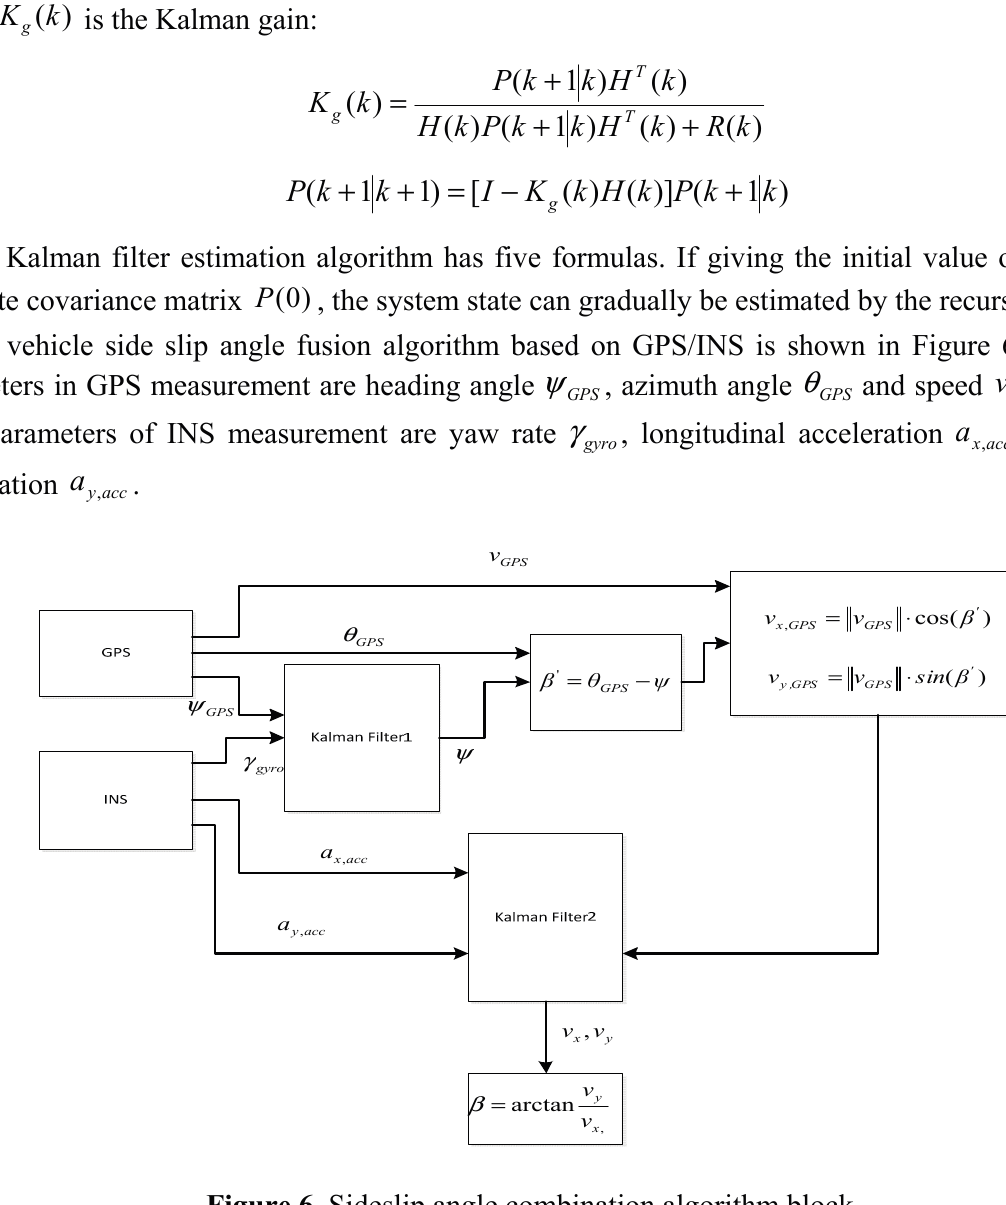
Figure 6. Sideslip angle combination algorithm